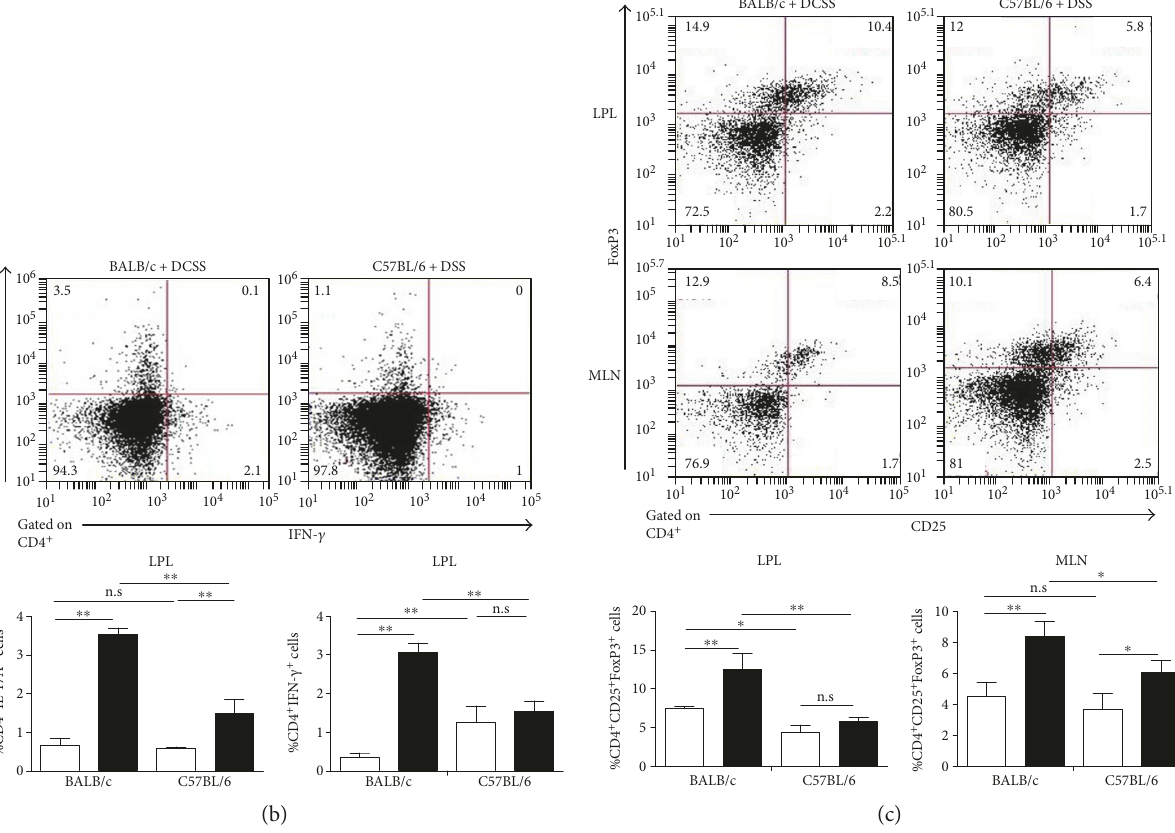
Figure 5: A di ff erential induction of Th17 and Treg responses in BALB/c and C57BL/6 mice following DSS challenge. (a) mRNA expression of various cytokines in LPLs and MLNs was analyzed by RT-PCR. Levels of mRNA were normalized to β -actin mRNA and expressed relative to unchallenged BALB/c mice. Data indicate the mean ± SD obtained from a representative of two independent experiments (each with n = 4 ). (b), (c) LPLs (MLN) were stained for cytokines and key nuclear immune factors and analyzed by FACS. Representative plots (left panel) and associated quanti fi cation displaying the mean ± SD values of the percentage of Th17 and Treg cells (right panel) are shown ( n = 3 mice per group). The data are representative of two independent experiments. Statistical di ff erences were evaluated by Student ’ s t -test. ∗ p < 0 05 ; ∗∗ p < 0 01 . In all assays, the physical (day 0) cell number of immune cell subtypes is 200,000/sample.